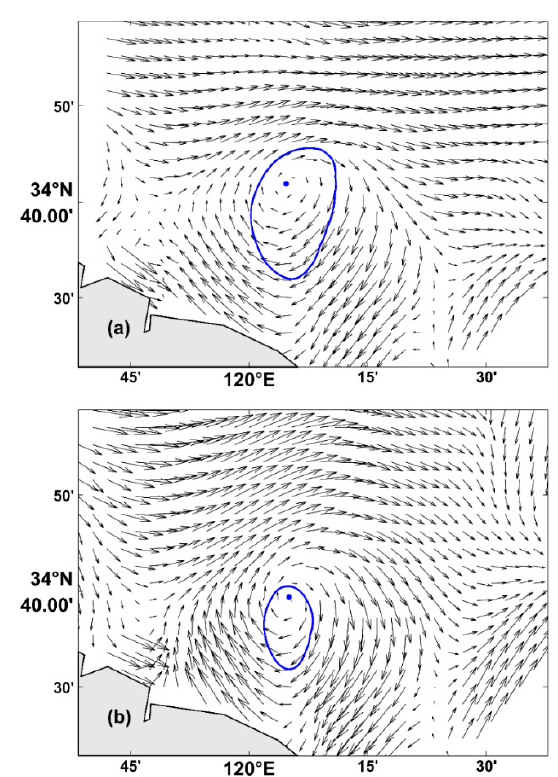
Figure 4. Examples of the eddy detection algorithm. Surface current velocity fields are obtained with HFRs at ( a ) 11:40 UTC on 10 July 2017 and ( b ) 12:40 UTC on 10 July 2017. The blue solid lines are eddy boundaries and the blue dots are centers of anticyclonic eddies, both estimated from the vector geometry (VG) method.